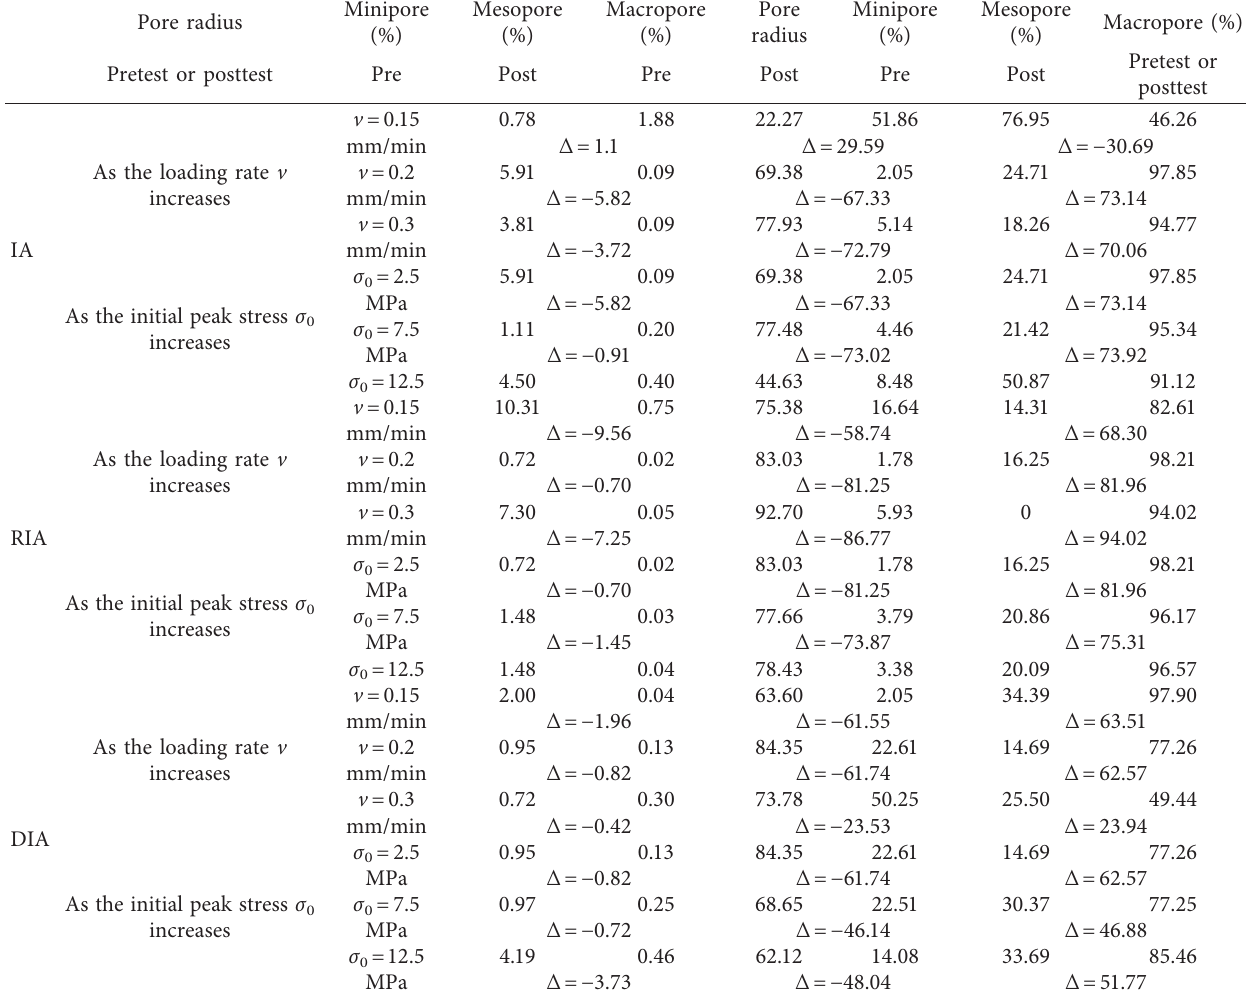
Table 6: Pore-radius distribution proportion at different loading rates and initial peak stresses before and after the test. Pore